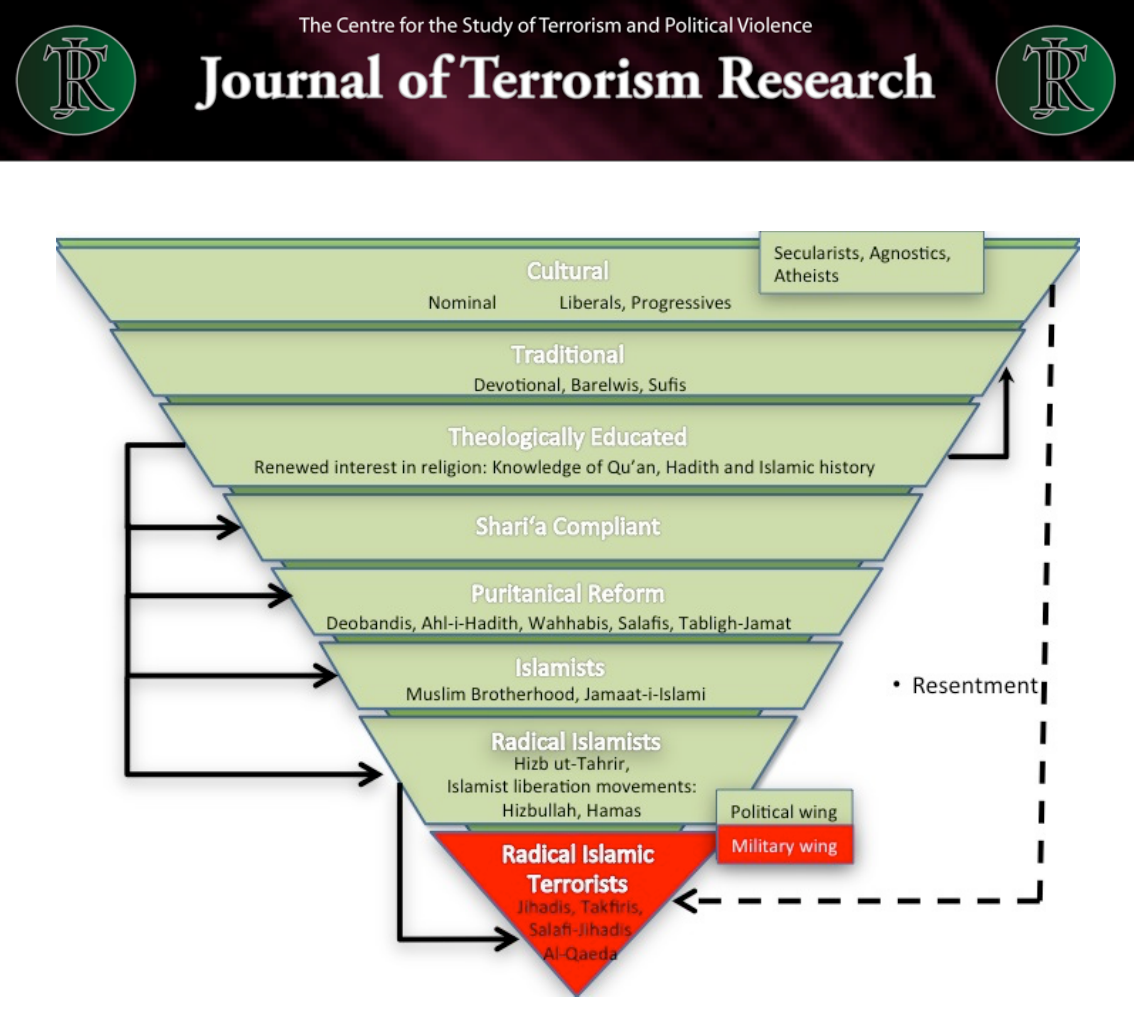
Source: Figure excerpted from Patrick Sookhdeo, Ideas Matter; How to Undermine the Extremist Ideology Behind al Qaeda , (New York: Mcgraw-Hill, 2011),